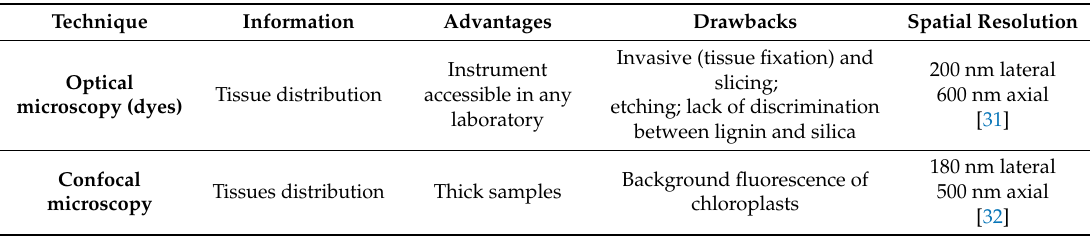
Table 1. Summary of the techniques surveyed in the present review for the study of plant silicification. Details of the information provided, advantages / drawbacks and spatial resolution are schematically